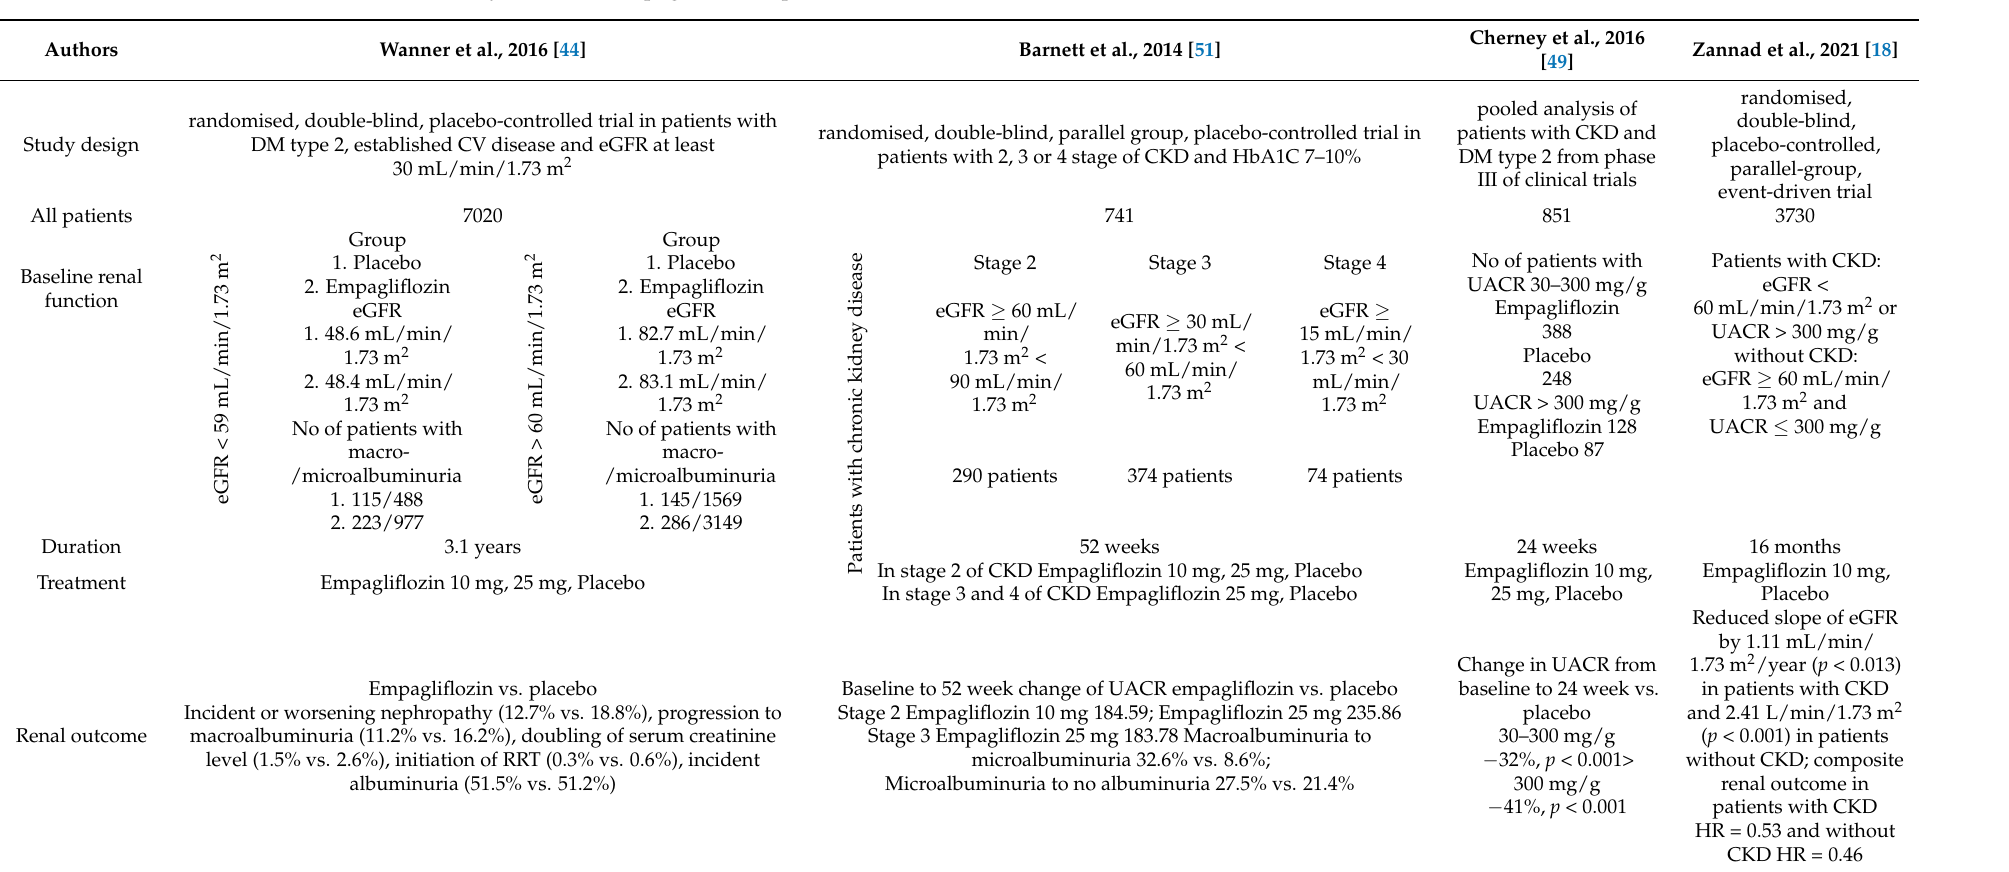
Table 2. Summary of trials of empagliflozin in patients with T2DM and CKD